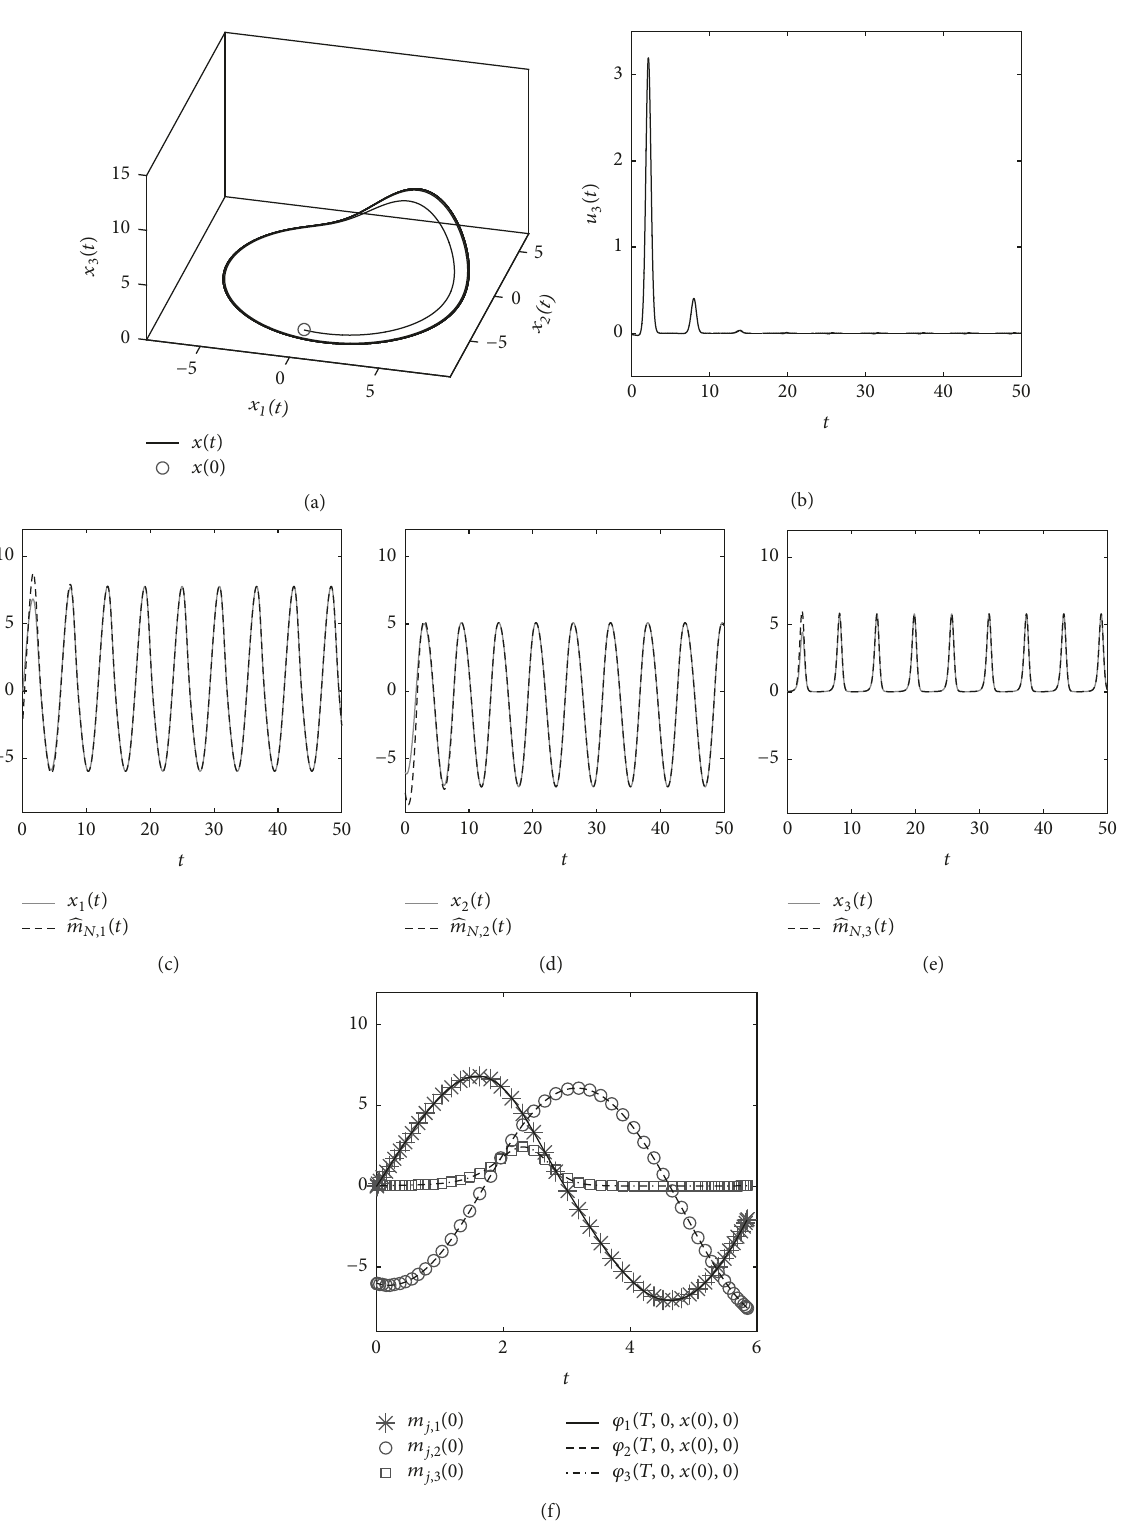
Figure 23: aPBC applied to the R¨ossler system with 𝑁 = 52 , 𝑘 = 1.85 , and 𝑘 𝑜 = 10 . (a) Trajectory in state space; (b) time-series of the control signal; ((c), (d), and (e)) time-series of the actual and predicted state variables; (f) time-series of 𝜑(𝑇,0,𝑥(0),0) and the initial value of the predicted states 𝑚 𝑗 (0)